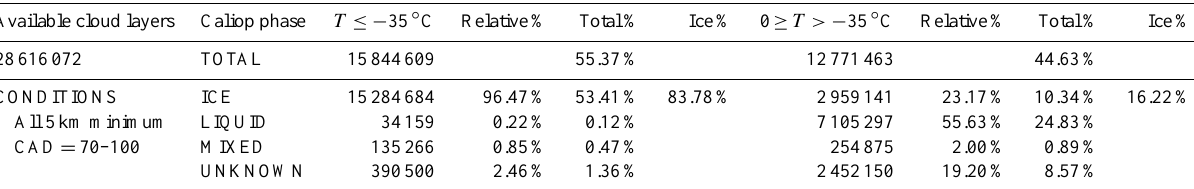
Table 3. Similar to Table 1; total number of cloud layers resolved in the 2012 CALIOP V3.02 L2_CPro-5km product; number of those clouds corresponding with cloud top height temperature ≤ − 35 ◦ C, including sub-sample totals and relative, total and ice percentages (as denoted) as function of CALIOP-distinguished cloud phase, and those corresponding with a cloud top height temperature ≤ 0 and > − 35 ◦ C, again with corresponding itemized cloud phase sample sizes and fractional percentages. Data have been filtered for polar stratospheric cloud occurrence.